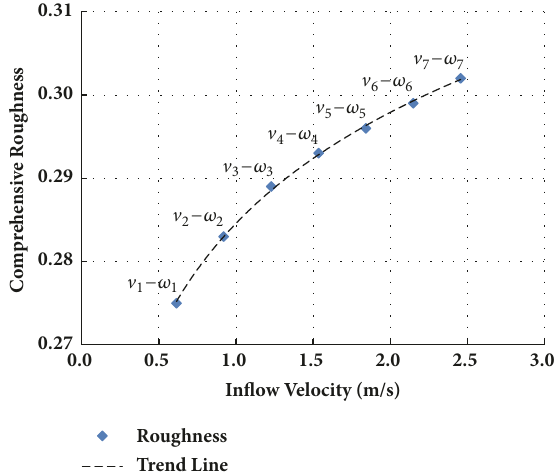
Figure 11: Relationship between inflow velocity and compositive